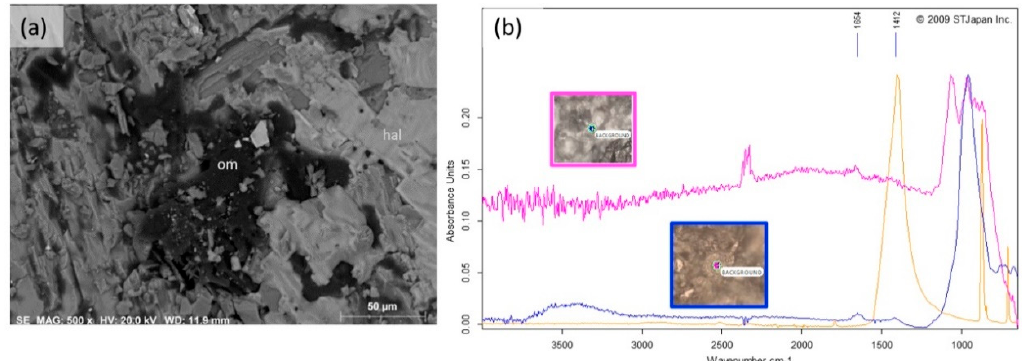
12 of 25 Figure 5. SEM images of a gabbro ‐ diorite specimen before (upper) and after (lower) SC CO 2 brine: ( a ) backscattered electron (BSE) images at 0 days; ( b ) BSE and EDS elemental maps distribution for silicon and carbon at 0 days; ( c ) BSE images after 64 days; and ( d ) BSE and EDS elemental maps distribution for silicon and carbon after 64 days, with preferential dissolution of clinopyroxene (circle) and carbon enrichment (organic accumulation) on the edge of specimen (arrow). plg—plagioclase, cpx— clinopyroxene, hal—halite.